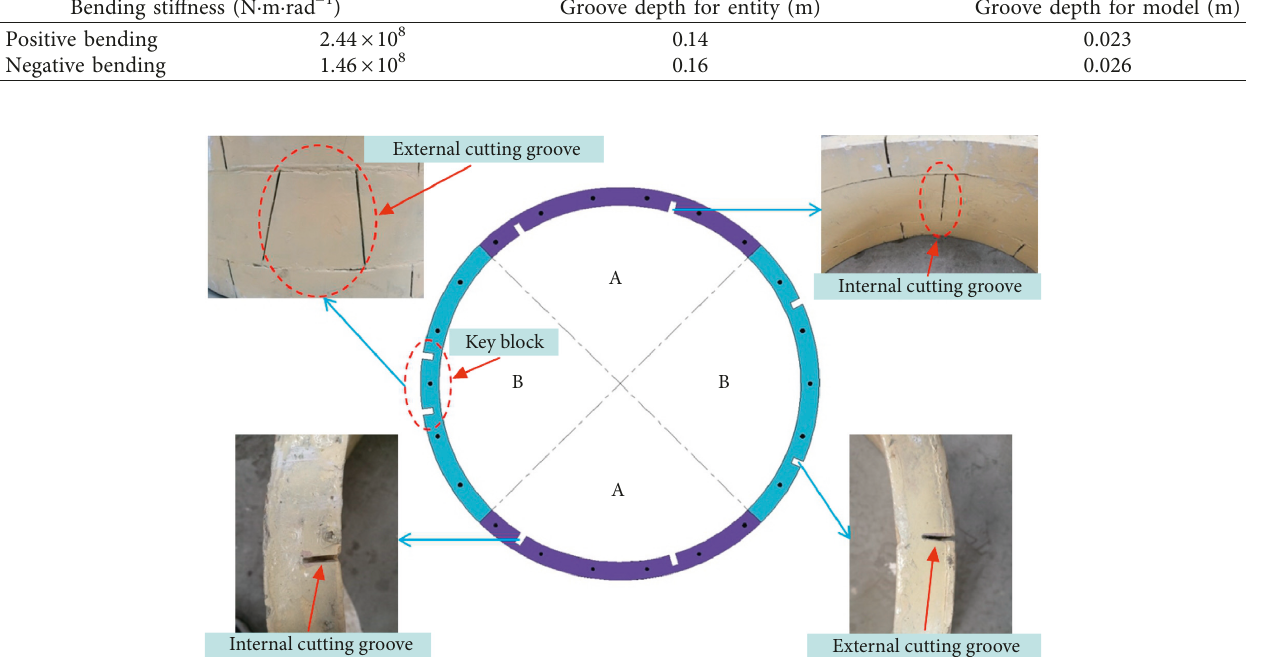
Figure 6: Groove of partition for segment joint.